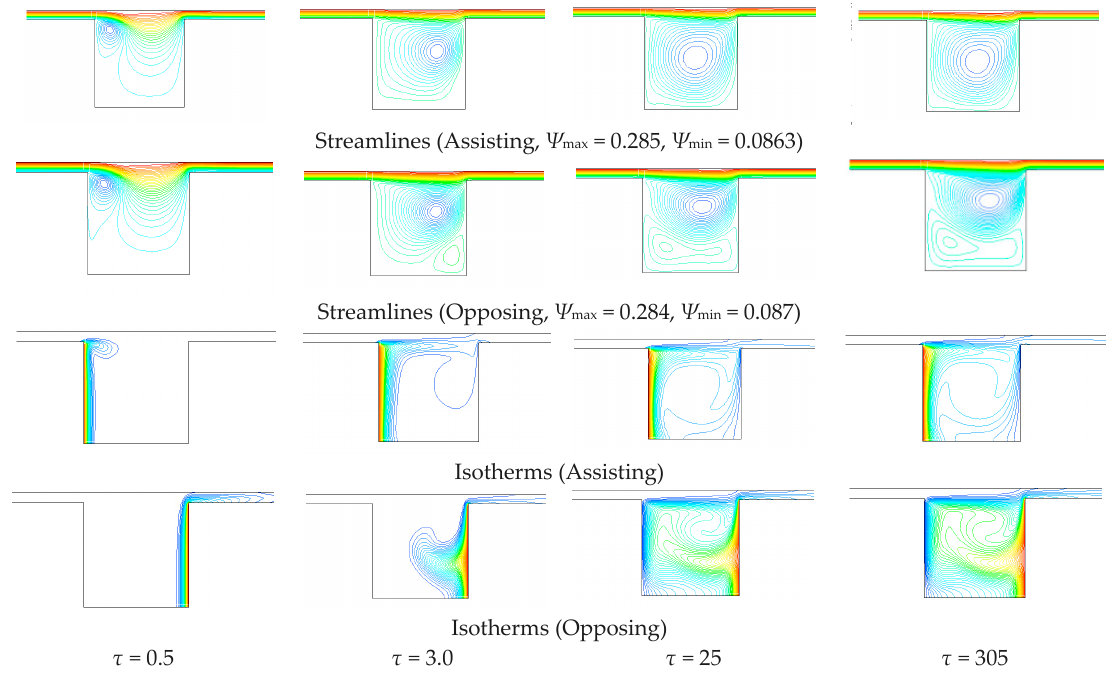
Figure 4. Streamlines and isotherms for Re = 100, aspect ratio (AR) = 1.0 and Ri = 13.20.